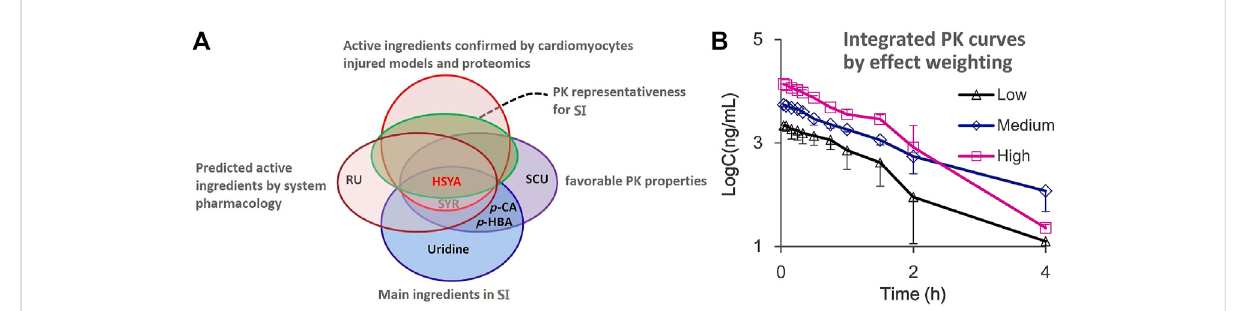
FIGURE 7 (A) Venn diagram of PK marker identi fi cation for SI and (B) the integrated drug plasma concentration-time curves by the effect weighting integrated method with the plasma concentration of two ingredients HSYA and SYR after i.v., administration of SI with high (4 ml/kg, Mean ± SD, n = 3), medium (2 ml/kg, Mean ± SD, n = 3), and low (1 ml/kg, Mean ± SD, n = 4)